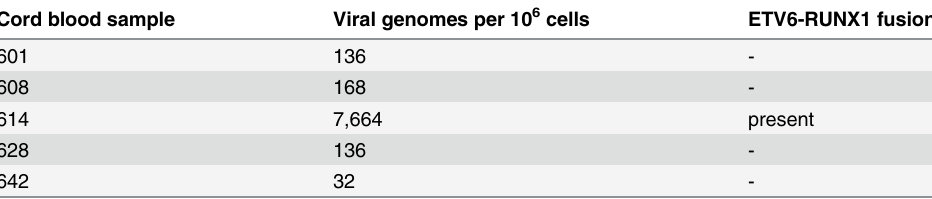
Table 3. Adenovirus genome load in selected adenoviral DNA-positive